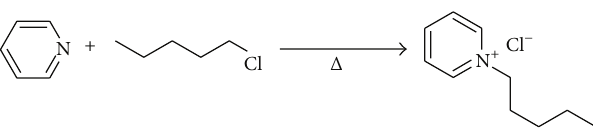
Scheme 1: Reaction scheme for the synthesis of 1-butylpyridinium